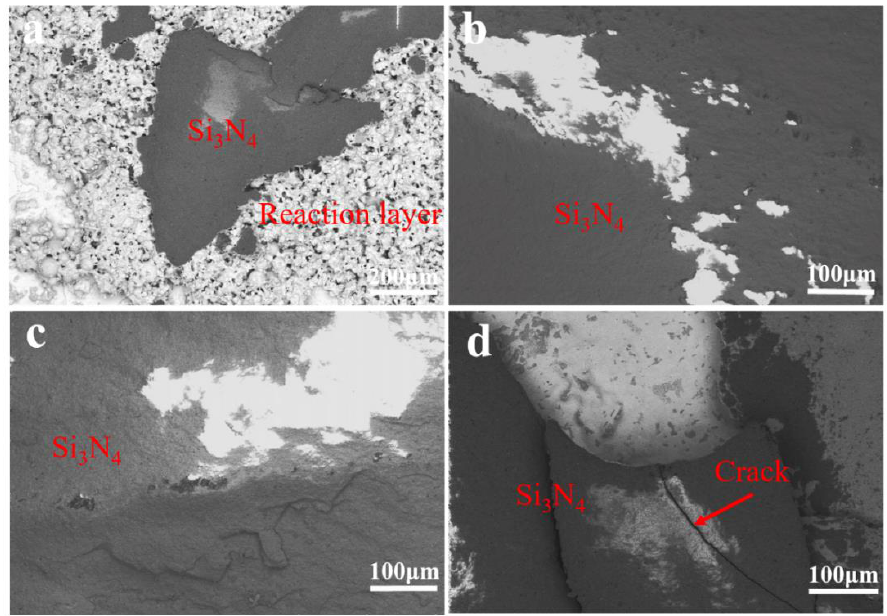
Figure 9. Fractographies of TiZrHfNbMo HEAs/AgCuTi/Si 3 N 4 joints brazed at different tempera- tures. ( a ) 800 ◦ C, ( b ) 820 ◦ C, ( c ) 840 ◦ C, ( d ) 860 ◦